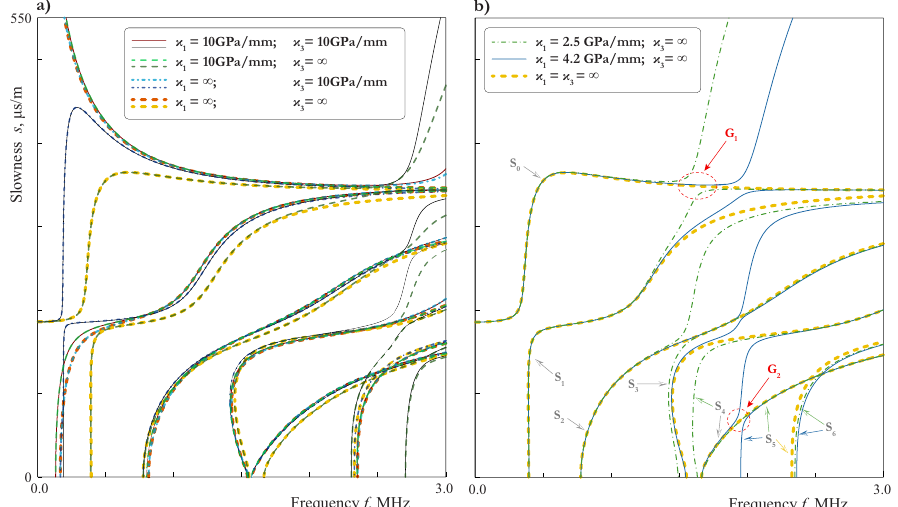
Figure 9. SCs of symmetric LWs propagating in 4.05 mm thickness plate (2 mm aluminium/50 µ m film/2 mm aluminium) with the imperfect contact for four different combinations of normal and tangential stiffnesses κ i ( a ) and symmetric LWs for two different values of the interface tangential stiffness if κ 3 = ∞ ( b